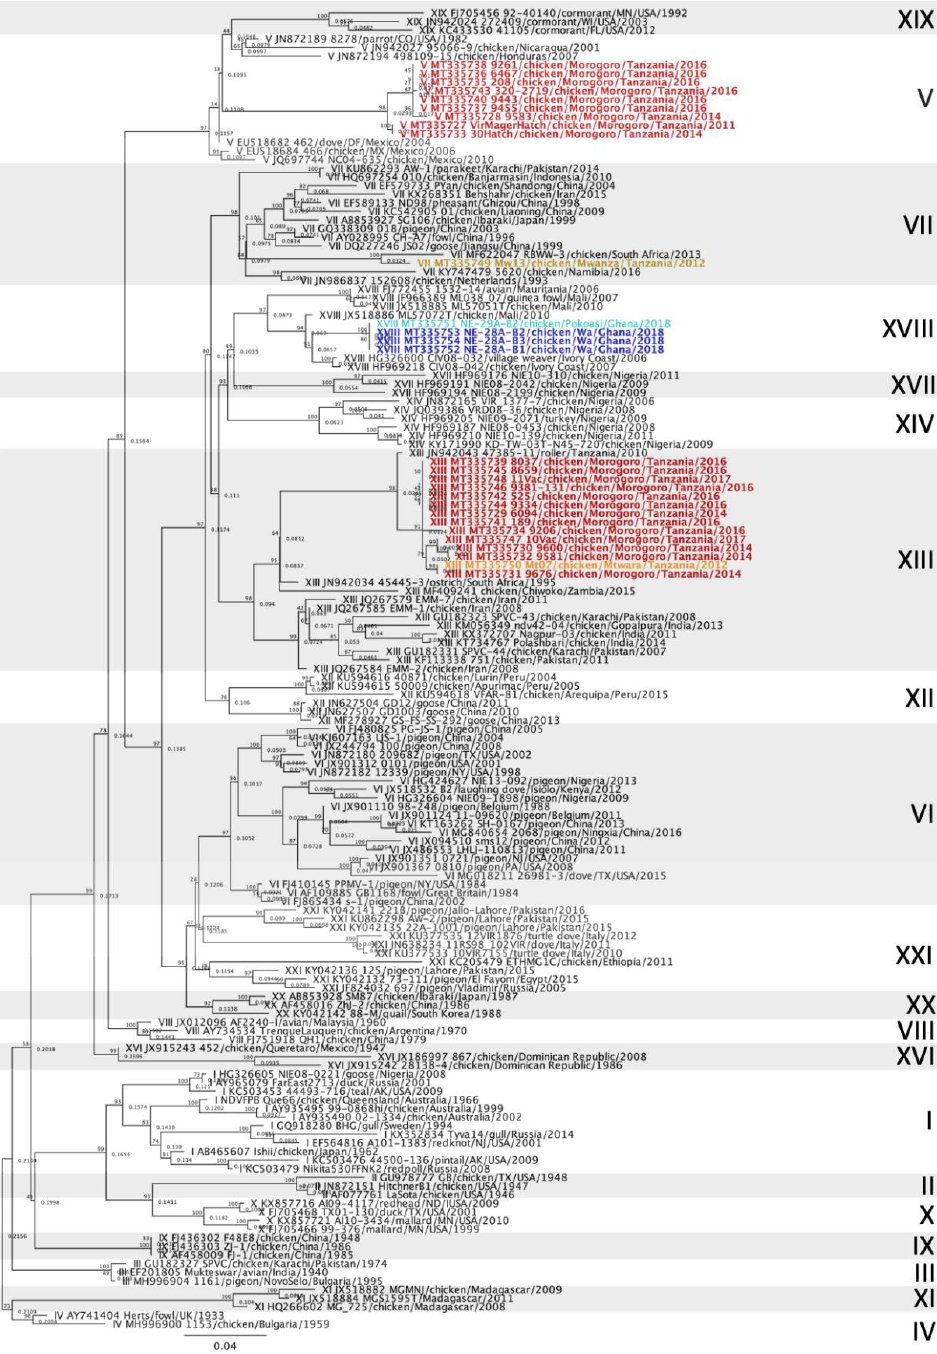
Figure 2. Phylogenetic analysis of Newcastle disease virus class II isolates using a 615-bp fragment of the fusion gene with the maximum likelihood method 1000 bootstrap replicates. Of the 153 sequences used, 28 were collected from diseased chickens from Tanzania and Ghana (bolded and colored) and 125 represent all class II genotypes as described by Dimitrov et al. [5]. The Roman numerals on the right represent the genotypes the isolates belong to. The colors represent the geographic location of the isolates (orange = Mtwara, red = Morogoro, yellow = Mwanza, light blue = Pokoasi and dark blue = Wa).